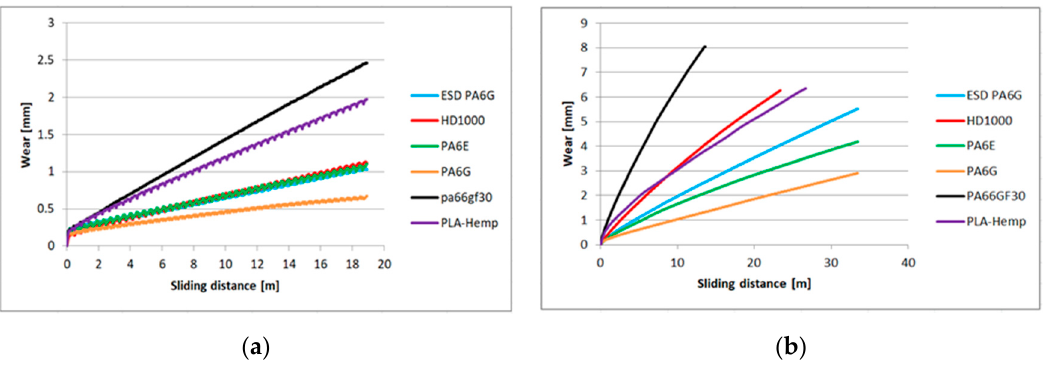
Figure 5. The relationship between the wear and sliding distance for several polymer types on P60 abrasive clothing: ( a ) lowest applied pv , ( b ) highest applied pv .